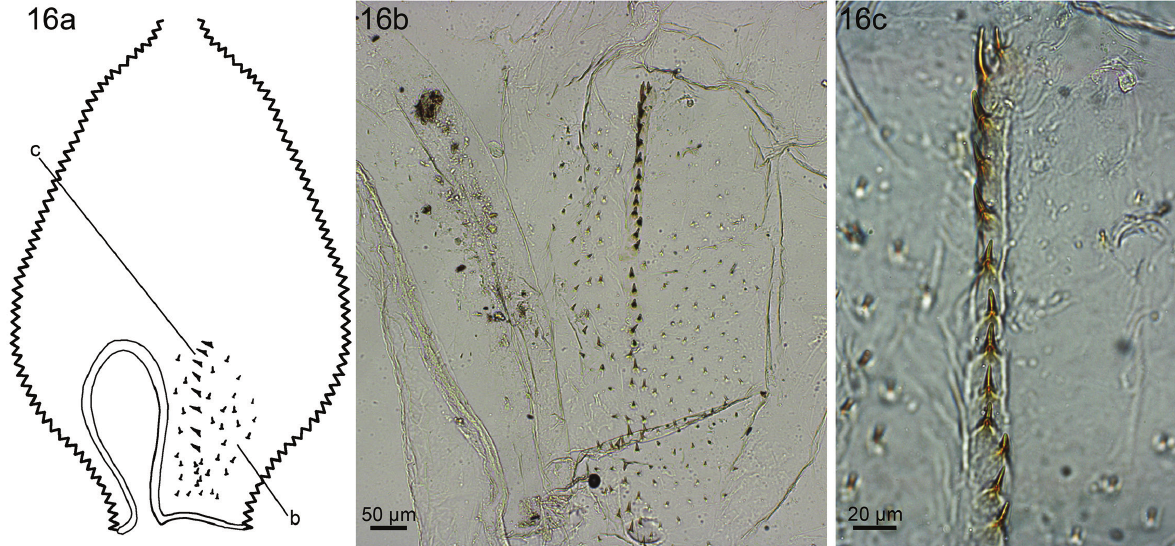
Figure 16. Mapinguaritermes peruanus . (a) Schematic drawing of P1 showing arrangement of spines. (b, c) Photomicrographs: (b) General view of the longitudinal row of stout spines, surround by robust spines; (c) Detail of stout